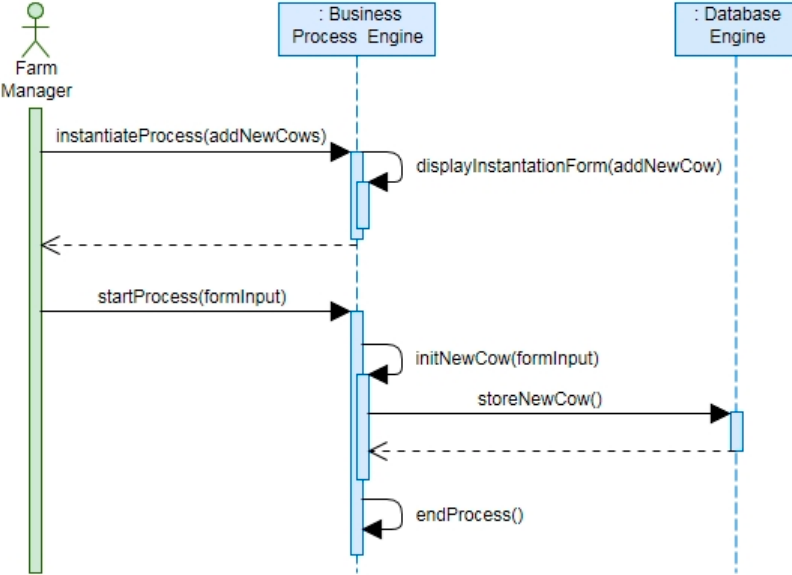
Figure 11. Activity diagram of a business process used to store a set of inputs in the software application database. In detail, the diagram shows the activities performed by different software components during the execution of the process “Add new cow”.